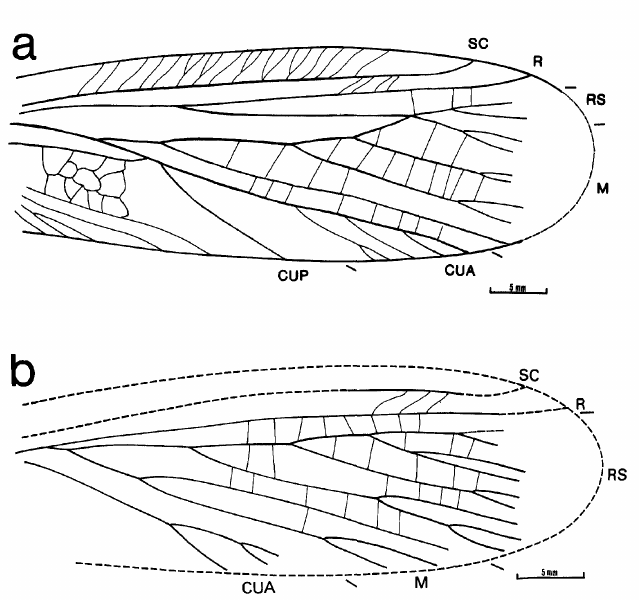
Fig. 20. Genentomum validum, drawings based on holotype no. USNM 38135. a. fore wing. b. hind